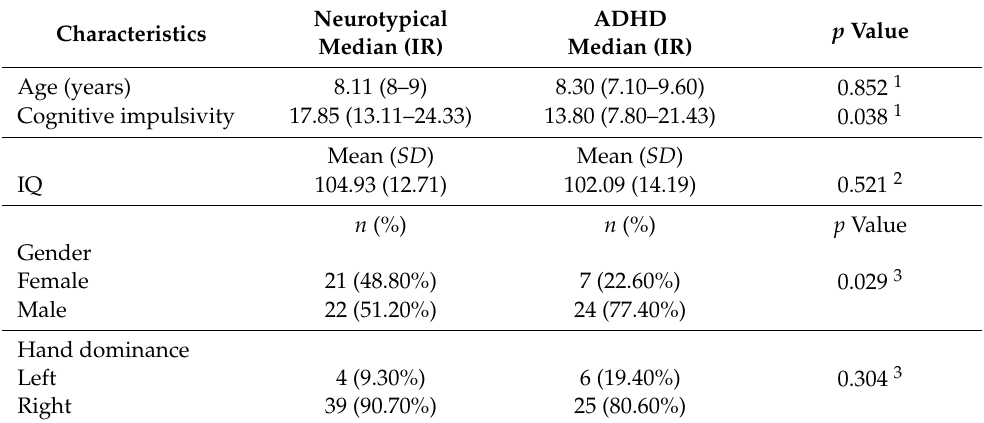
Table 1. Sociodemographic characteristics, intelligence quotient, hand dominance, and cognitive impulsivity by